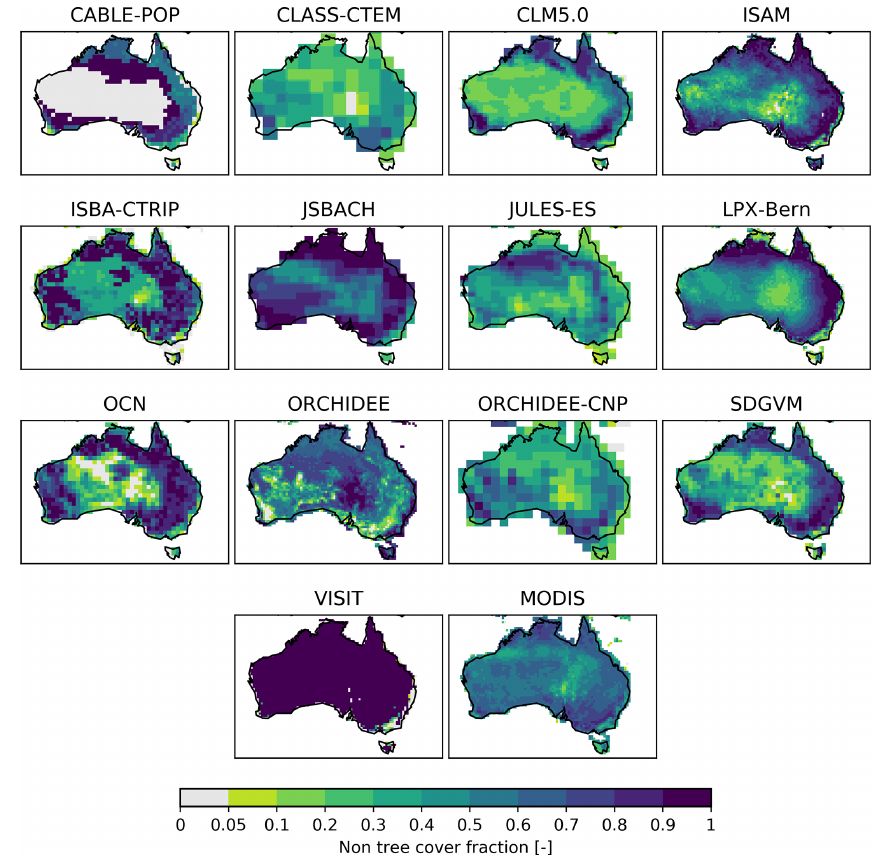
Figure 9. Land-cover fraction of non-tree vegetation averaged over 2001–2018. Non-tree vegetation here shows the sum of all natural C 3 and C 4 grasses as well as C 3 and C 4 pasture and agriculture and savanna PFTs in the TRENDY models. The MODIS panel shows the non-tree fraction variable from the MODIS/Terra Vegetation Continuous Fields dataset. White areas are missing